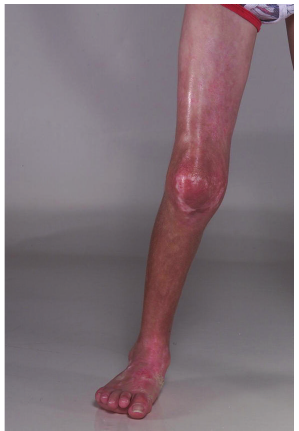
Figure 3: Linear morphea affecting the leg.